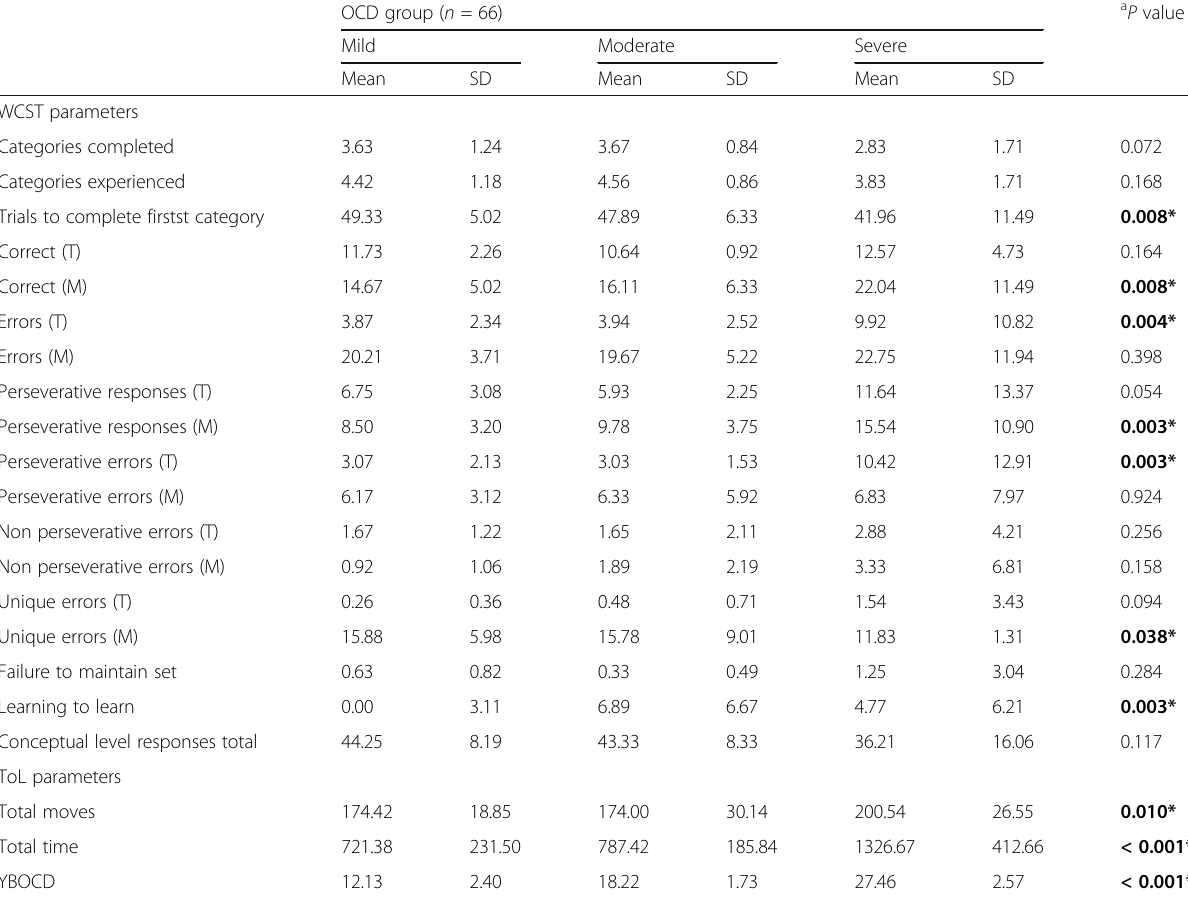
Table 5 Relation between OCD symptoms severity and EF according to YBOCD score among OCD group ( n =